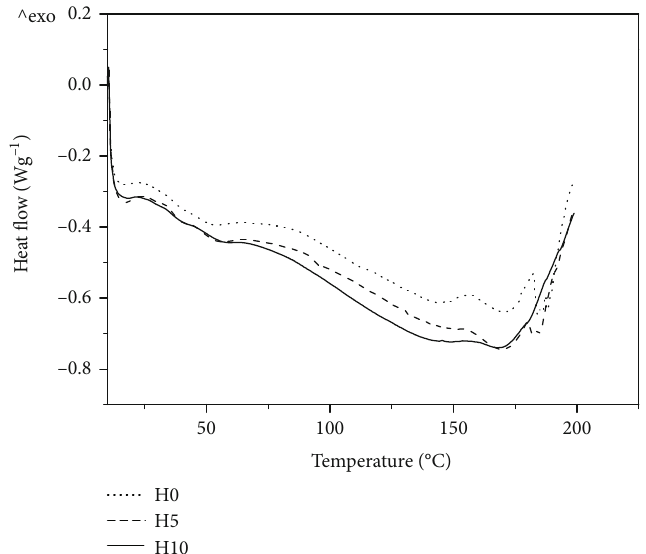
Figure 10: DSC thermogram of hydrogels cross-linked by 5% CA (H5), 10% CA (H10), and non-cross-linked hydrogel (H0).